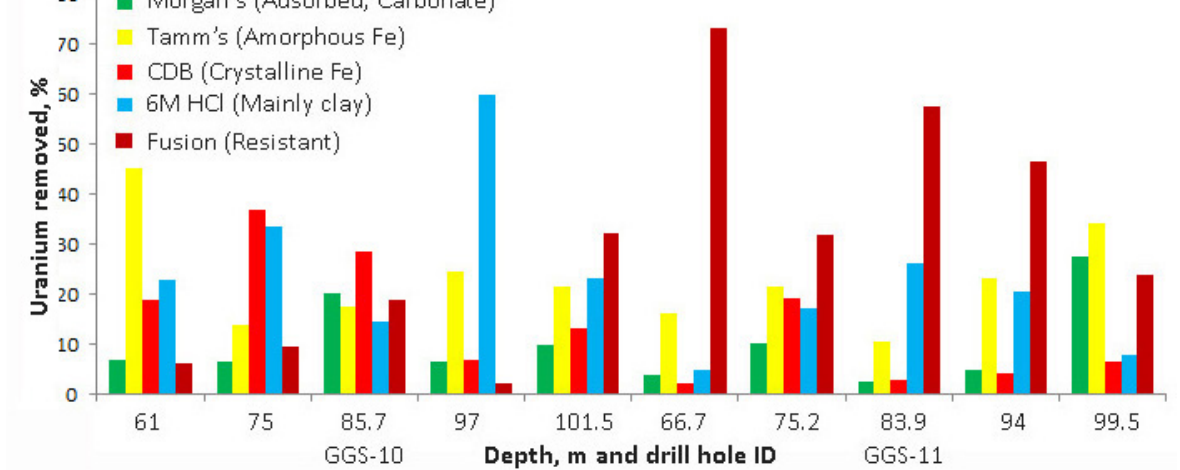
Figure 2. Distribution of uranium (%) in extracted phases.